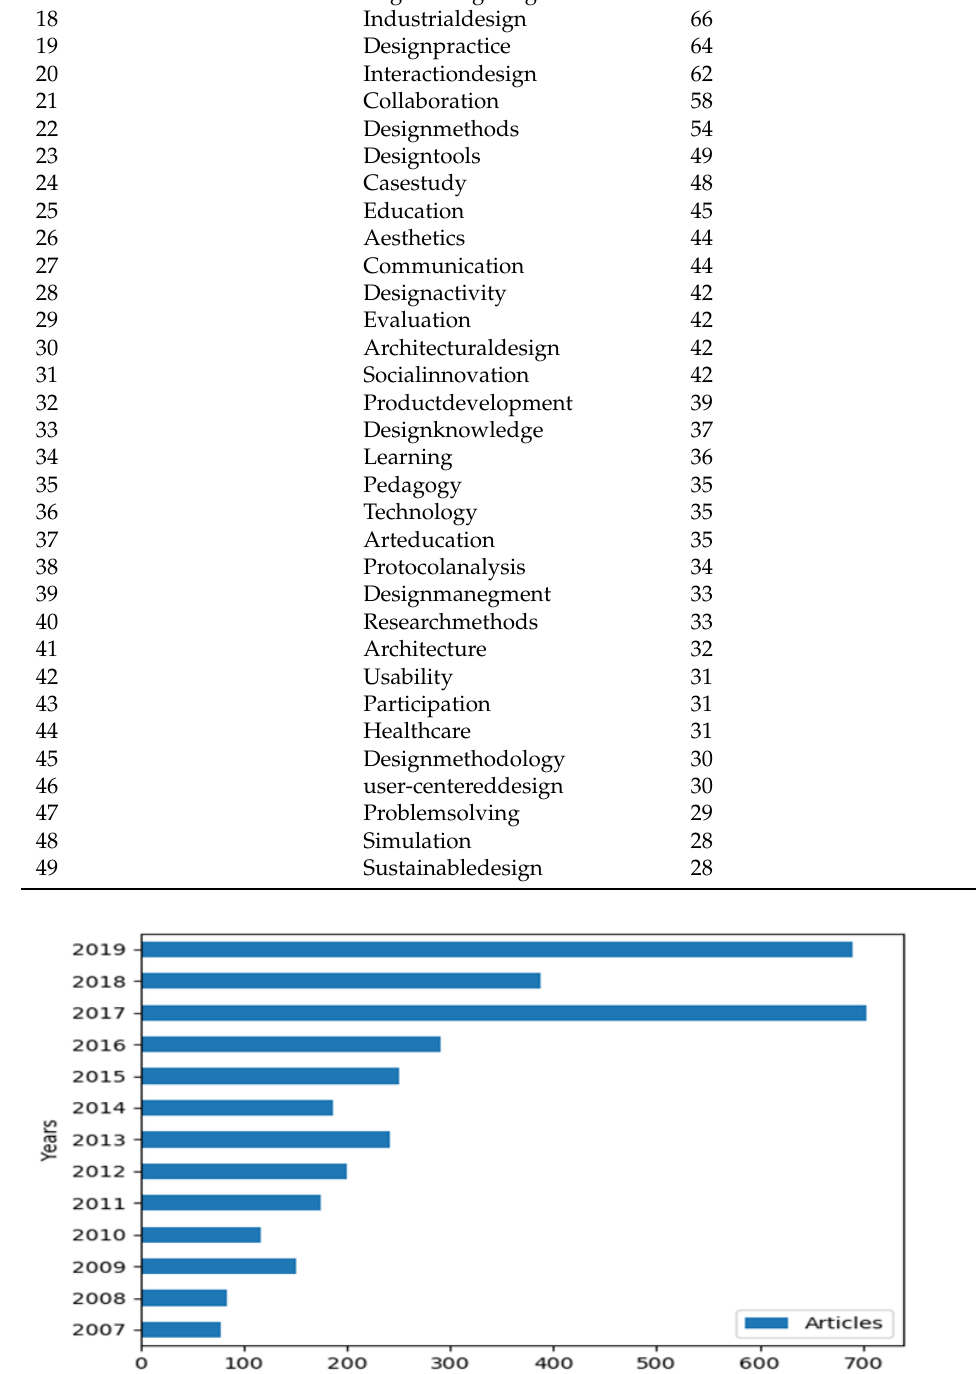
Figure 2. Distribution of publication per